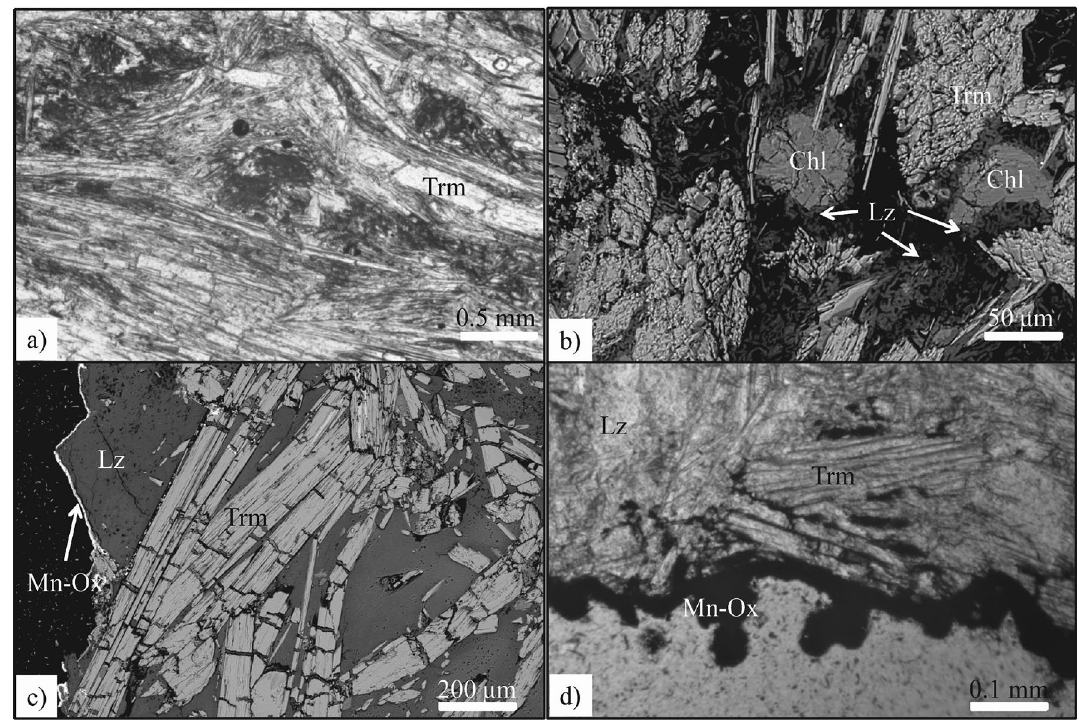
Figure 2. ( a ) Sample SMA1971-214 observed with polarized light optical microscopy (plane-polarized light). Tremolite (Tmr) fibres with orientation are grouped in sheaf-like clusters: the darkest regions are mainly basal sections while lighter ones are lateral sections. Detail of folded and kinked tremolite by perpendicular overgrowth of another bundle. ( b ) SEM image of tremolite (Tmr), secondary rounded chlorite (Chl) and late lizardite (Lz) around crystals and filling fractures. ( c ) SEM image of late lizardite (Lz) domain with tremolite (Tmr) fibres at the border of the sample coated by Mn-oxides (Mn-Ox). ( d ) The Mn-oxides (Mn-Ox) coating envelops the sample and spreads